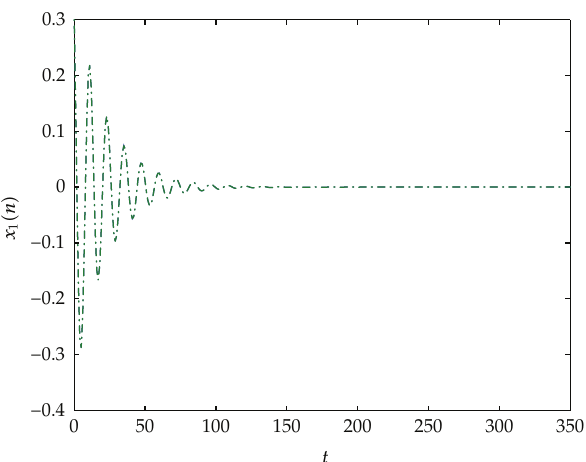
Figure 1: The equilibrium (cid:2) 0 , 0 (cid:3) is asymptotically stable. The initial value and parameter D are (cid:2) 2 , 3 (cid:3) and 38 / 15,